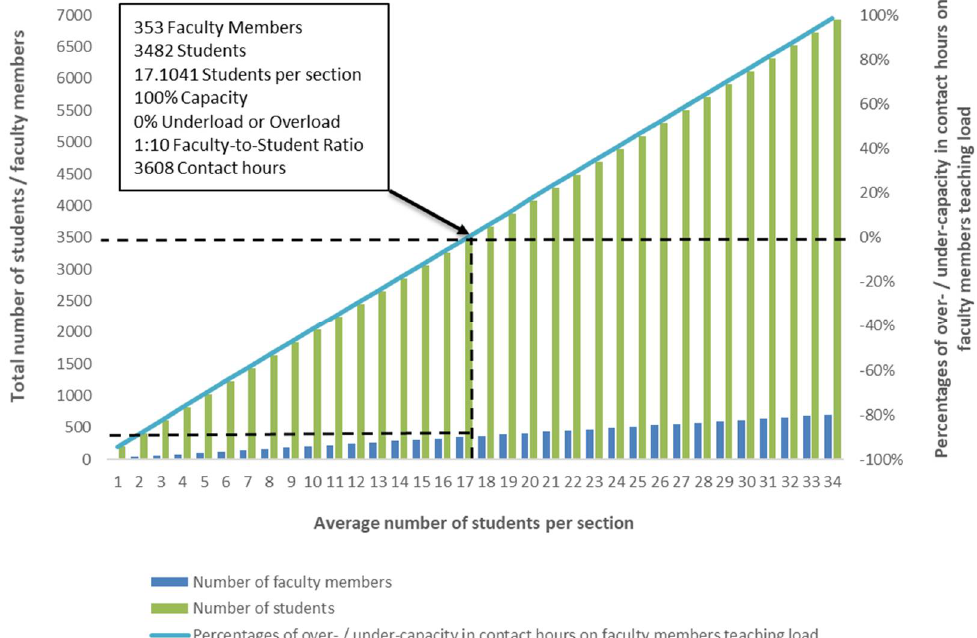
Figure 5. Utilization levels pertaining to the number of faculty members and the number of students and their relationship with the average number of students per section.